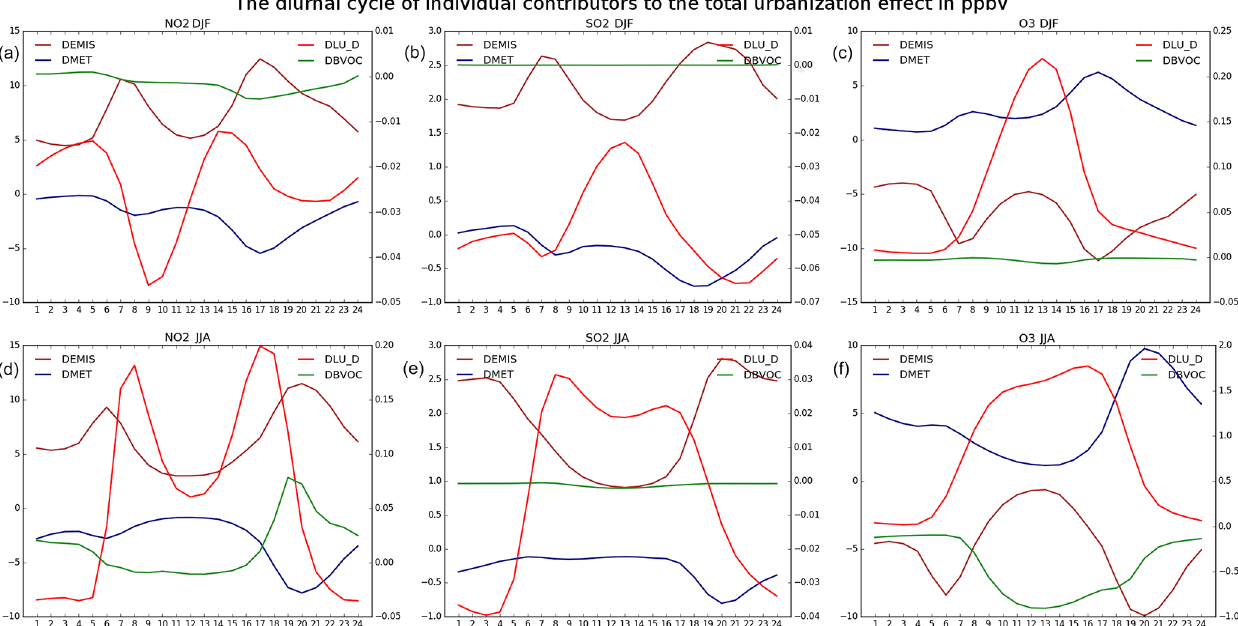
Figure 10. The 2015–2016 average diurnal cycle of the individual contributors to RUT for NO 2 (a, d) , SO 2 (b, e) , and O 3 (c, f) as a DJF (a– c) and JJA (d–f) average. The brown and blue lines stand for the two stronger contributors (DEMIS and DMET, left y axis), while red and green stand for the weaker contributors (DLU_D and DBVOC, right y axis). Units are in parts per billion by volume (ppbv). Times are in UTC (i.e., the local time is + 2h in JJA and + 1h in